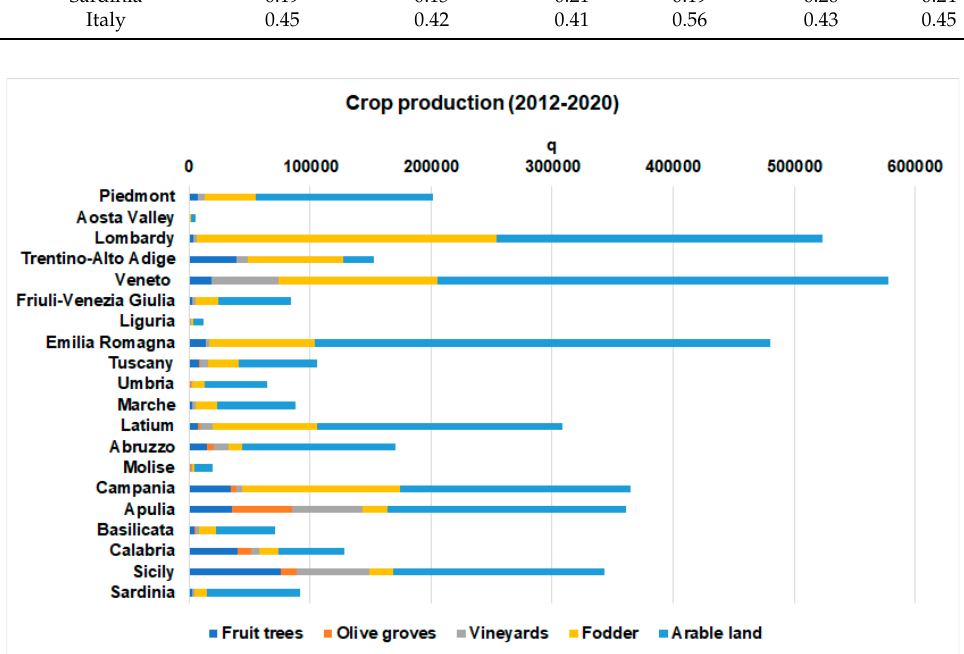
Figure 4. Estimation of crop production (quintals) for five agricultural classes in 2012 at the regional level.